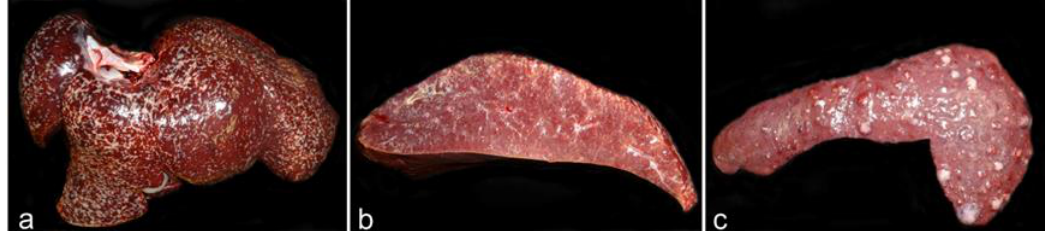
Figure 4. Liver and spleen from dog 2 . ( a ) Enlarged liver with irregular whitish lines with diffuse distribution. ( b ) Section of the liver with whitish lesions throughout the parenchyma. ( c ) Enlarged spleen with multifocal whitish nodular lesions.